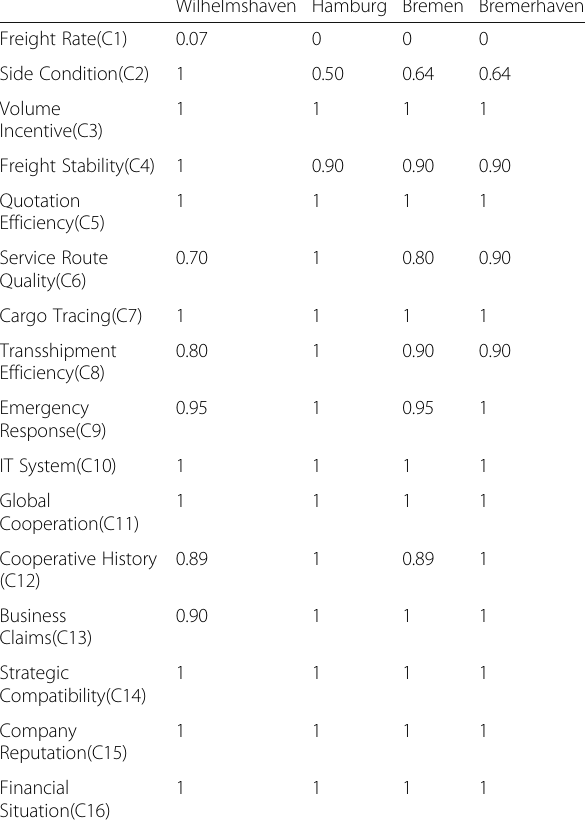
Table 18 Standardized data for ports of Wilhelmshaven, Hamburg, Bremen, and Bremerhaven. (Source: Authors) Wilhelmshaven Hamburg Bremen Bremerhaven